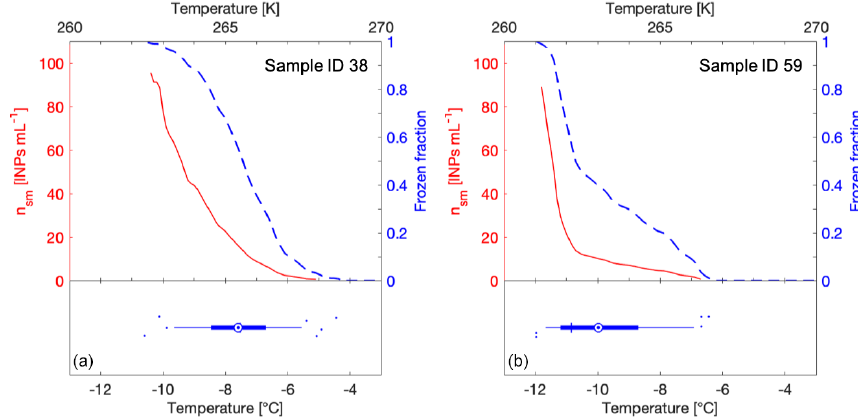
Figure 2. Examples of FF curves (blue y axis), freezing temperature boxplots (bottom of the graphs) and INP concentrations ( n sm ) (red y axis) generated for two snowmelt samples (from sample 38 and from sample 59; see Table S1). In the boxplot, the thin blue vertical line shows the median and is equal to T 50 , the mean is shown as a blue circle with a concentric dot. The blue box ranges from the 25th to the 75th percentiles, whereas the whiskers extend from the 5th to the 95th percentiles. Outliers are drawn as blue dots and scattered vertically to avoid overlapping. Panel (a) shows a linear FF curve with overlapping T 50 and median values in the boxplot, whereas panel (b) shows a FF curve with a kink with T 50 and median values differing by at least 1 ◦